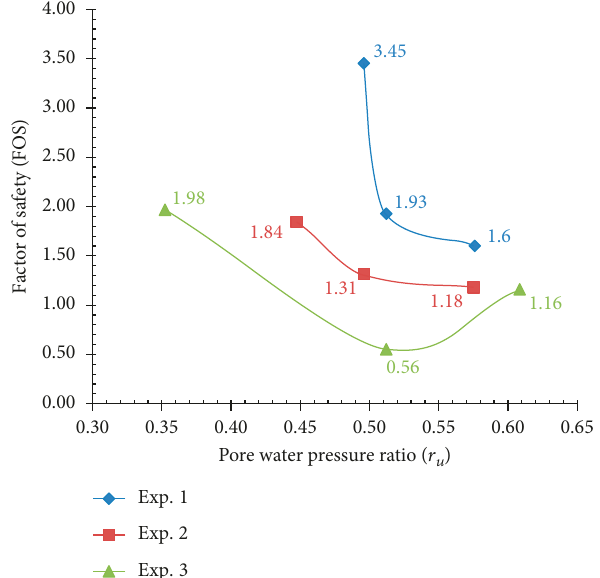
Figure 14: Factor of safety against pore water pressure